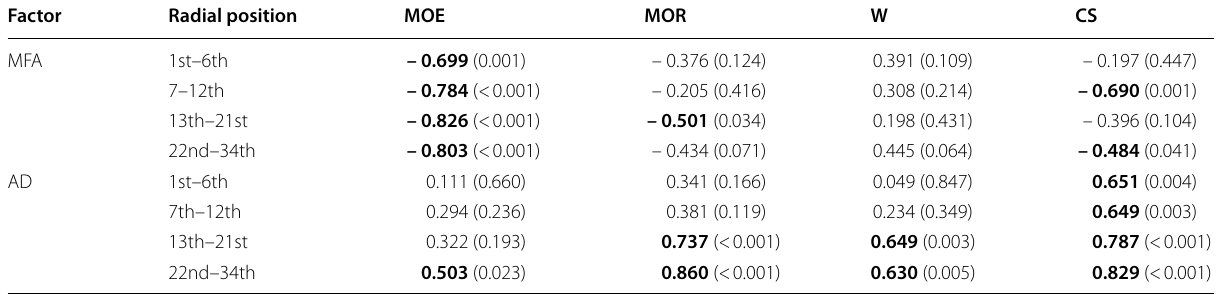
Number of sample trees